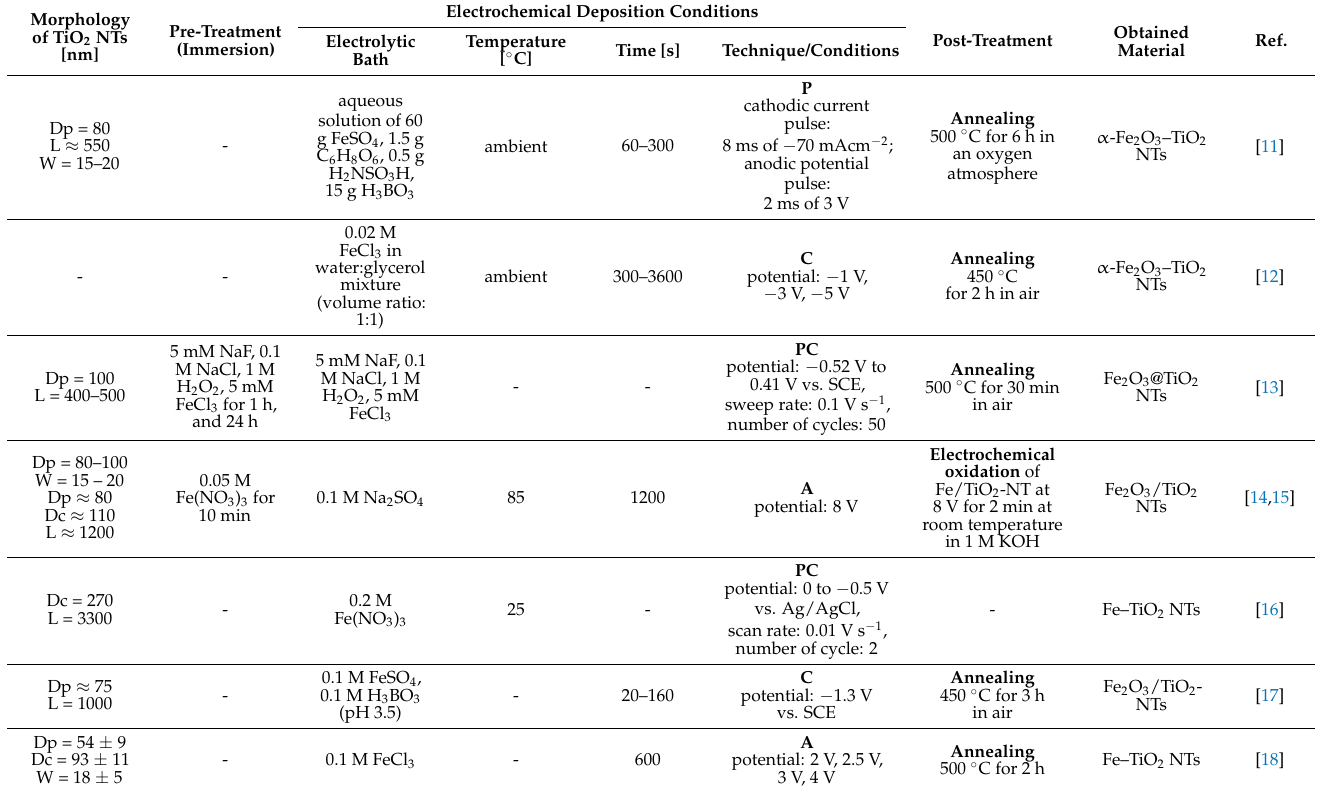
Table 1. Procedures for the synthesis of Fe/Fe 2 O 3 –TiO 2 materials by electrochemical deposition of iron/iron oxides in anodic TiO 2 nanotubes (NTs). Dp—pore diameter (inner); Dc—interpore distance (outer); L—length; W—wall thickness; A—anodic; C—cathodic; P—pulsed; PC—potential